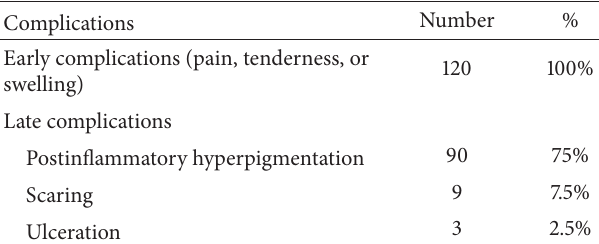
Table 3: Side effects of intralesional injection of 2% zinc sulfate solution in the treatment of common